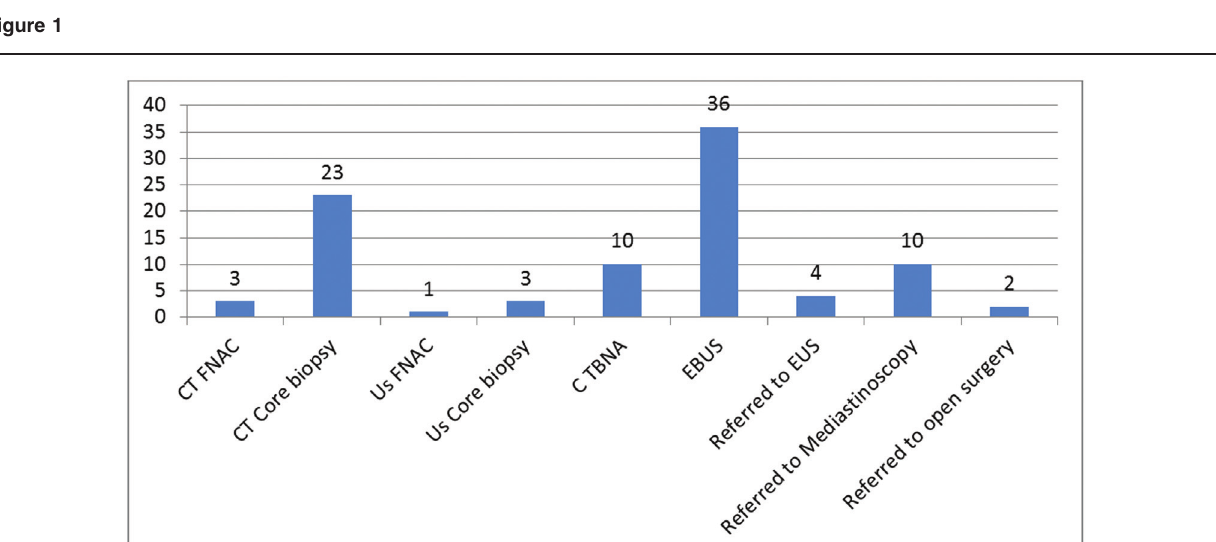
Different modalities of sampling used and number of cases diagnosed by each modality. CT, computed tomography; C TBNA, conventional transbronchial needle aspirate; EBUS, endobronchial ultrasound; EUS, endoscopic ultrasound; FNAC, fine-needle aspiration cytology; US,